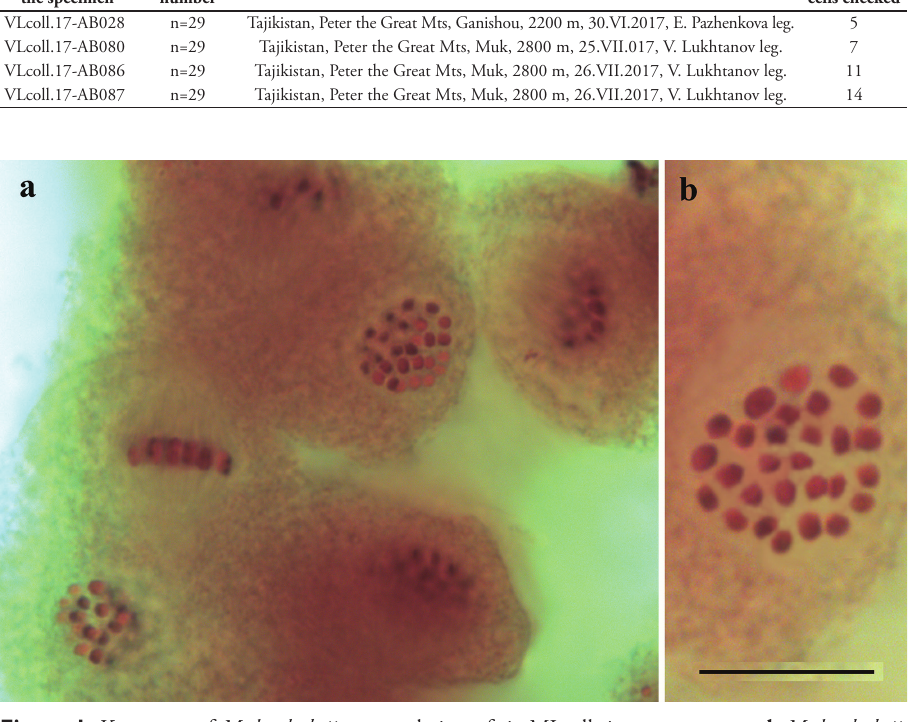
Figure 1. Karyotype of M. kotshubeji a general view of six MI cells in a spermatocyst b M. kotshubeji , AB080, MI, n=29. Scale bar: 10